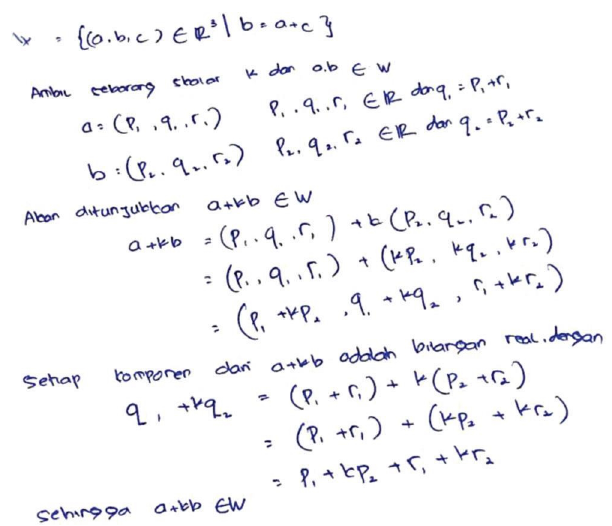
F IGURE 2: The students ’ written